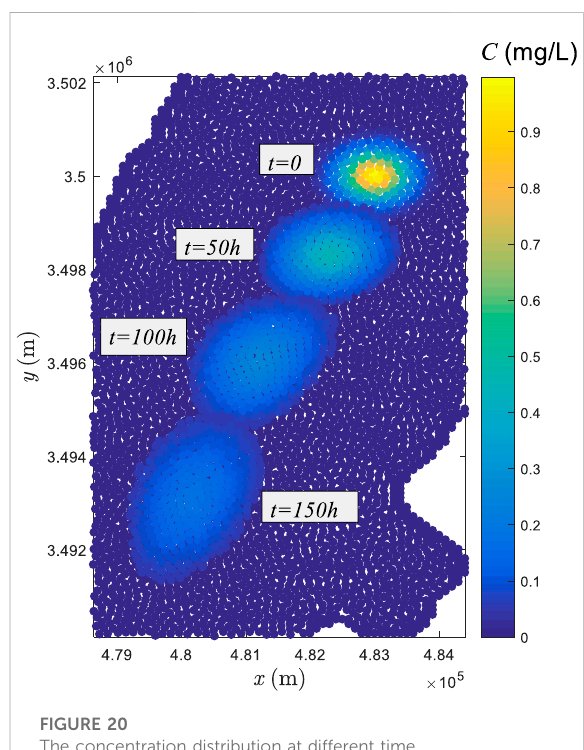
FIGURE 20 The concentration distribution at different